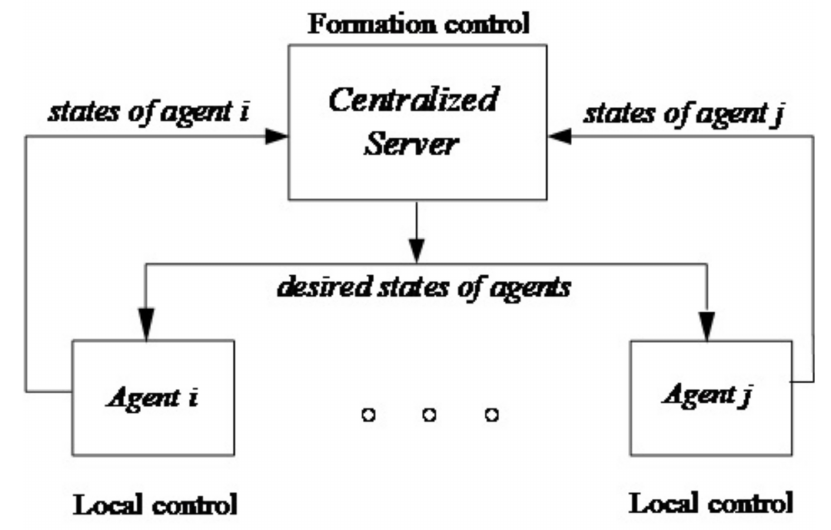
Figure 7. Centralized architecture based on the virtual structure